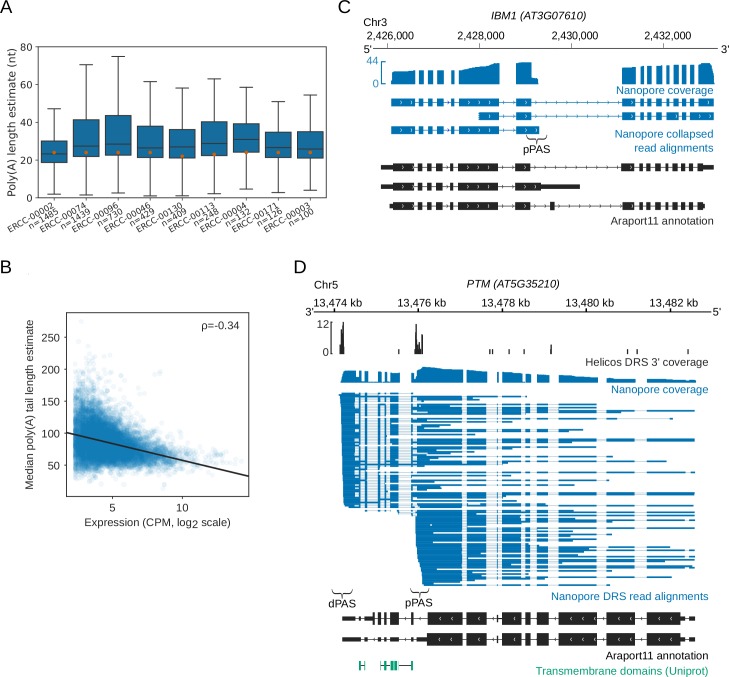
3′ end processing is revealed by nanopore DRS.(A) Poly(A) tail length estimates for ERCC spike-in controls. Boxplots showing distribution of poly(A) length estimates for ERCC spike-in controls with more than 100 mapped reads for which tail length could be successfully estimated. Expected poly(A) tail lengths are shown as orange points. (B) The RNA poly(A) tail length negatively correlates with the gene expression level. Expression in log2 scale of counts per million (CPM) obtained from nanopore DRS data is plotted against the median poly(A) tail length. ρ, Spearman’s correlation coefficient; black line, locally weighted scatterplot smoothing (LOWESS) regression fit. (C) Nanopore DRS identified known 3′ polyadenylation sites in RNAs transcribed from the IBM1 (AT3G07610) locus. Blue track, nanopore DRS coverage; blue, isoforms detected by nanopore DRS; black, Araport11 annotation; PAS, proximal polyadenylation site. (D) Nanopore DRS identified novel 3’ polyadenylation sites in RNAs transcribed from the PTM (AT5G35210) locus. Black (on the top), Helicos DRS 3’ coverage; blue track, nanopore DRS coverage; blue, isoforms detected by nanopore DRS; black (on the bottom), Araport11 annotation; green, five annotated transmembrane domain regions from Uniprot entry F4JYC8 (PTM_ARATH) that mapped to exons; pPAS, proximal polyadenylation site; dPAS, distal polyadenylation sites.Figure 2—figure supplement 1—source data 1.Poly(A) tail length estimations generated from ERCC spike-in reads – Figure 2—figure supplement 1A.Figure 2—figure supplement 1—source data 2.Per gene poly(A) tail length estimate distributions generated from Col-0 reads - Figure 2—figure supplement 1B.